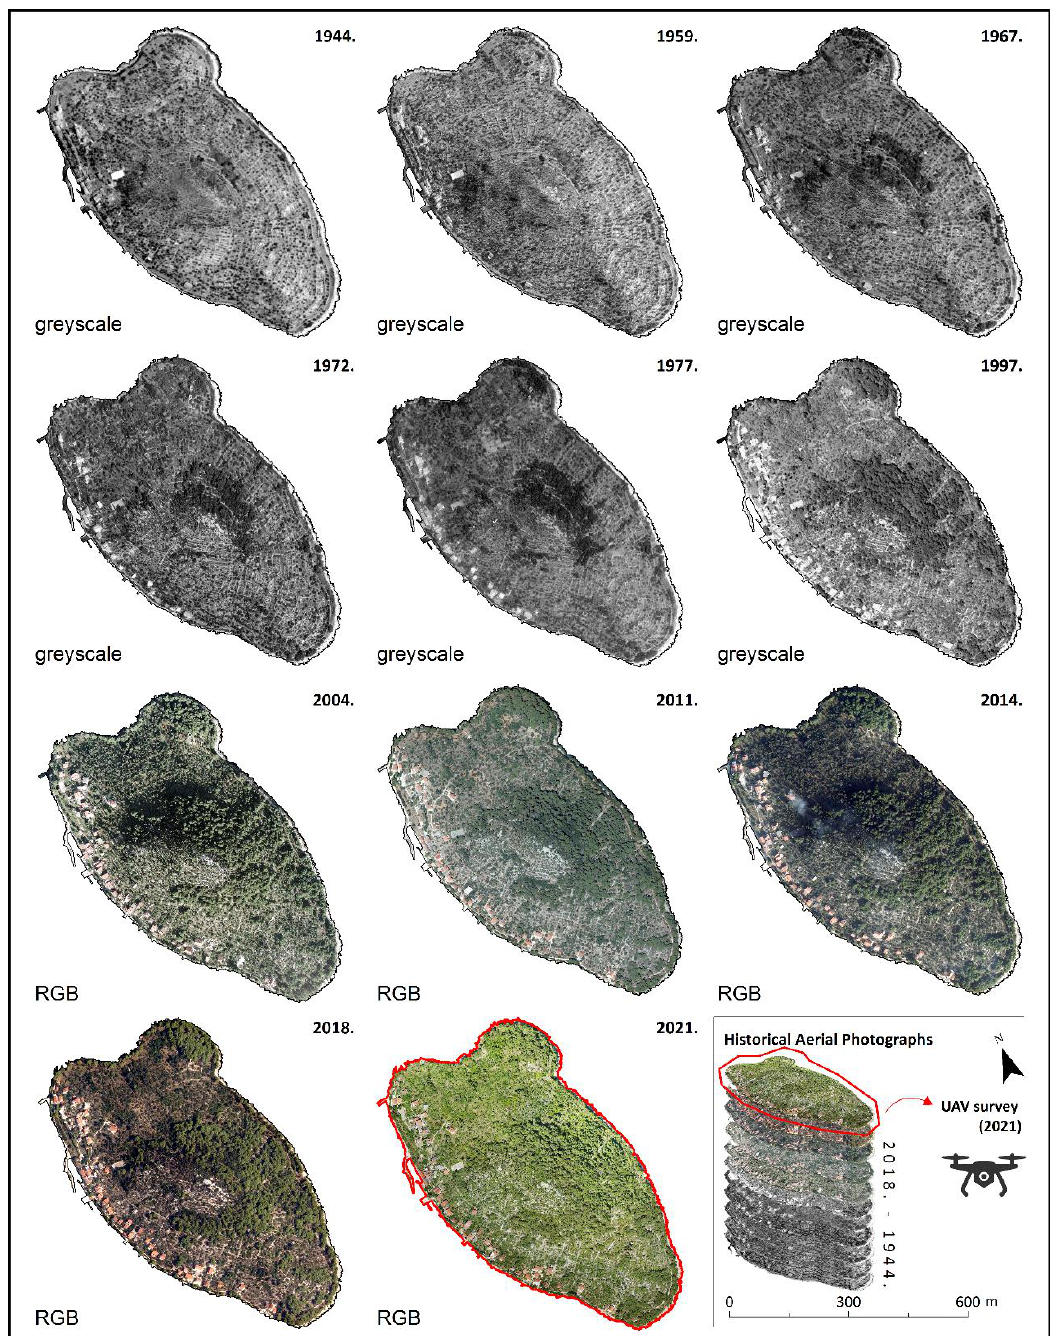
Figure 7. Overview of input data (HAPs and DOP derived from UAV survey) used for LUCC anal- ysis.